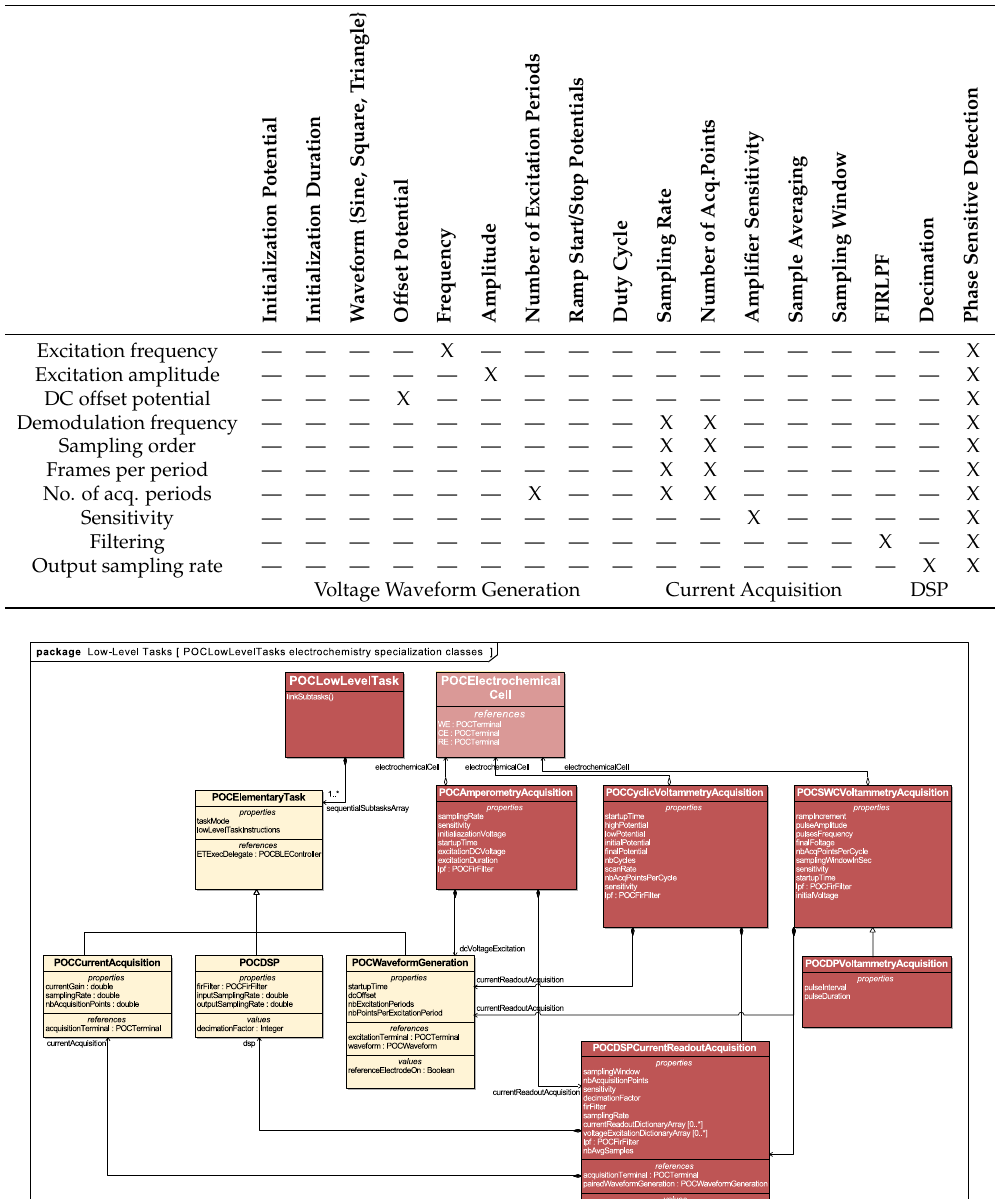
Table 2. Functional composition of a lock-in amplification acquisition. The acquisition settings, i.e., design variables of the function, can be mapped to the different parameters available through the elementary tasks offered by the platform.